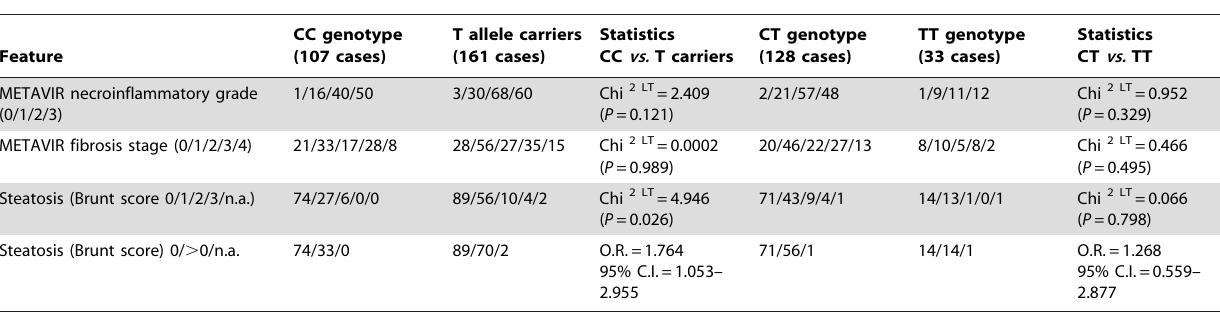
Table 2. Analysis of histological features in relation with the rs12979860 genotype in 268 patients with chronic hepatitis C.